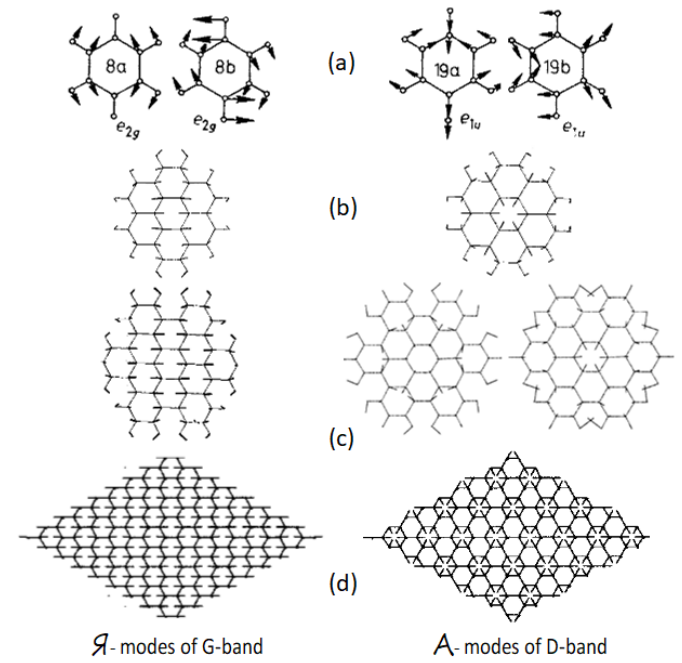
Figure 3. ( a ) benzene; ( b ) Figure 3. Vibrational forms of selected normal vibrations: ( a ) benzene; ( b ) coronene; ( c ) hexabenzocoronene; ( d ) a perfect 2D lattice of graphene. Composed of data from [34] and [40].